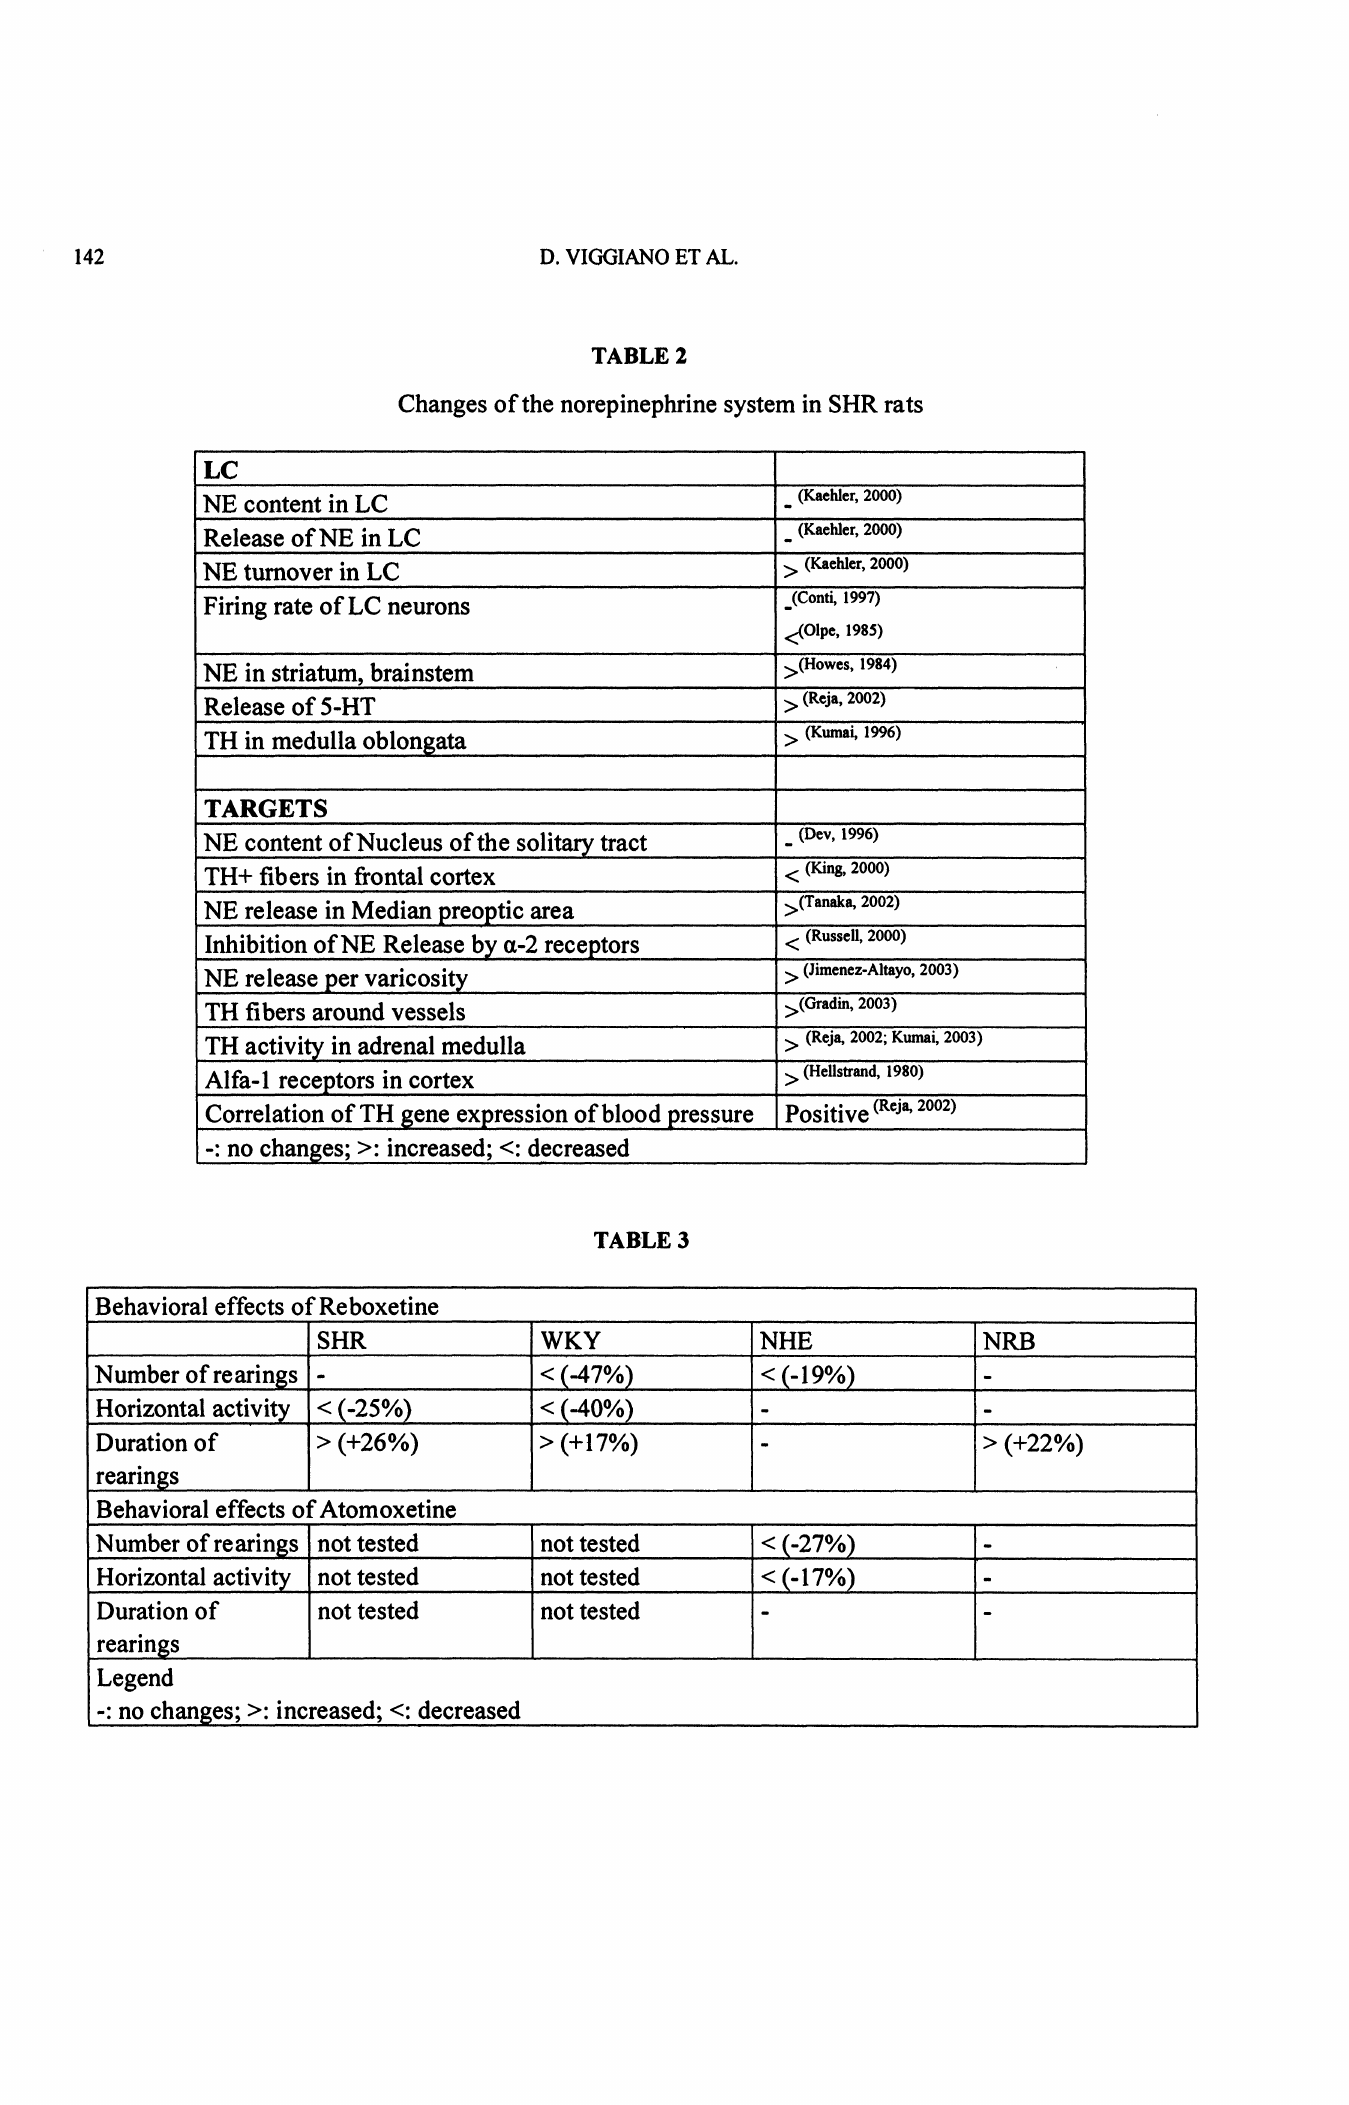
Changes of the norepinephrine system in SHR rats